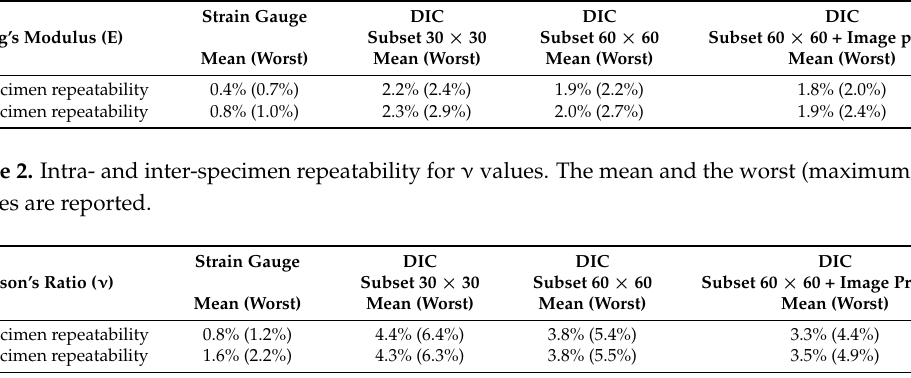
Table 1. Intra- and inter-specimen repeatability for E values. The mean and the worst (maximum) CV values are reported.